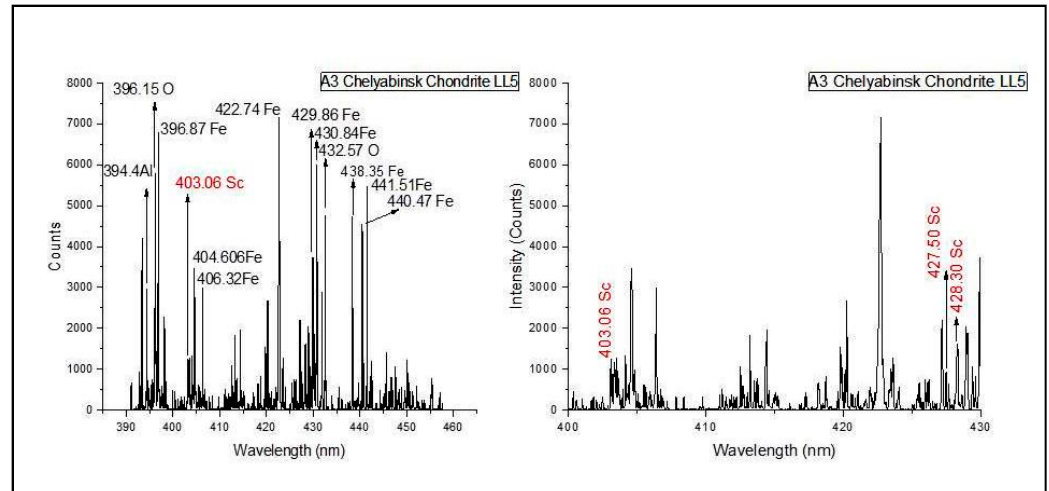
Figure 4. LIBS spectra recorded for sample A3 for full wavelength range and for a selected wavelength range of 400 nm to 430 nm showing the presence of REEs.